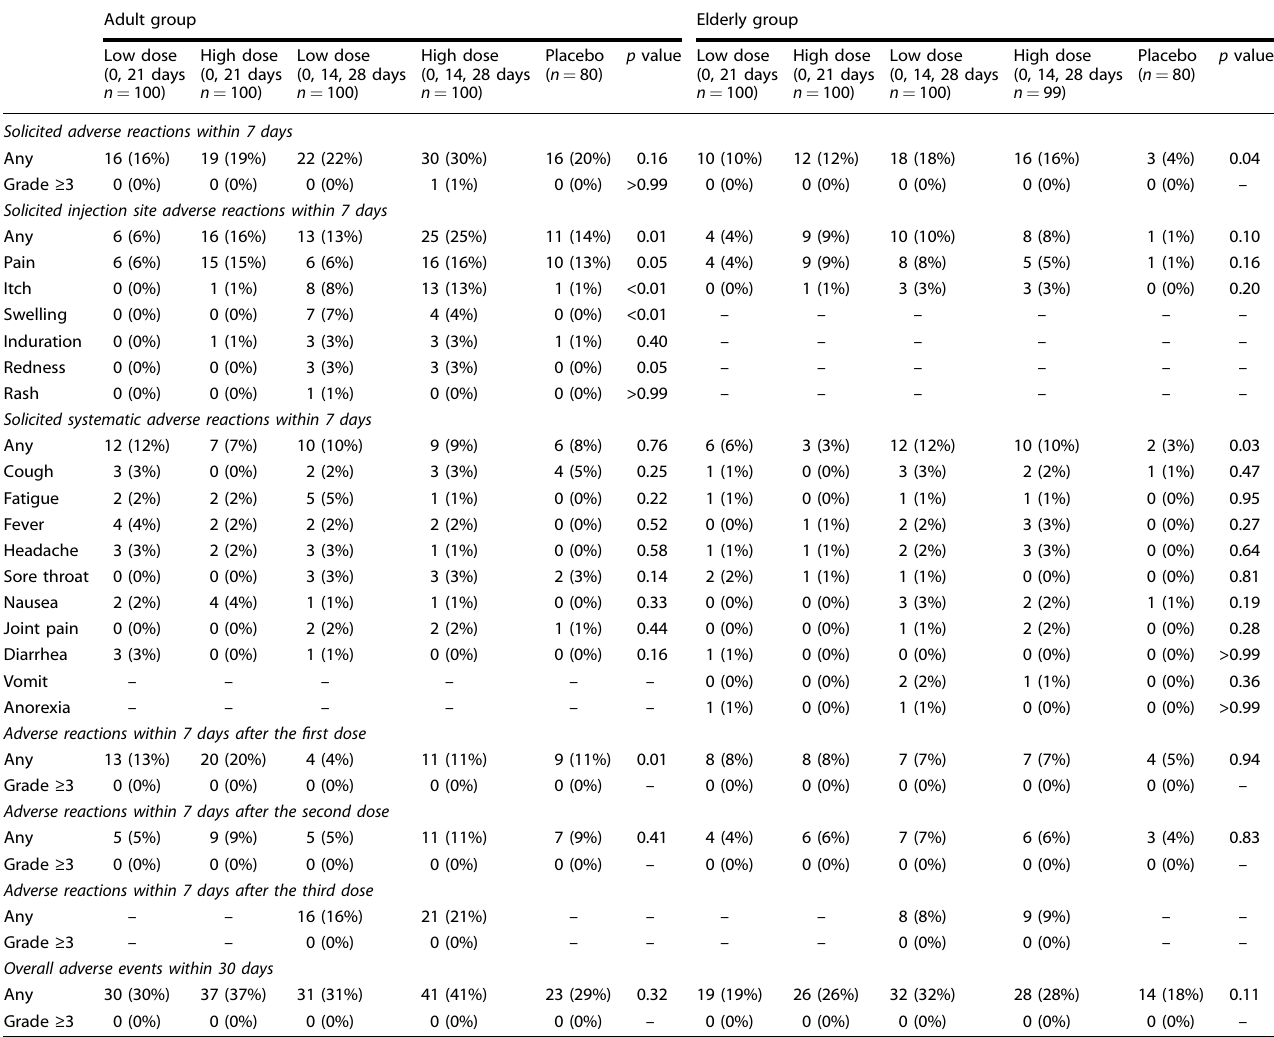
Table 3. Adverse reactions within 7 days and overall adverse events within 30 days after vaccination in phase 2